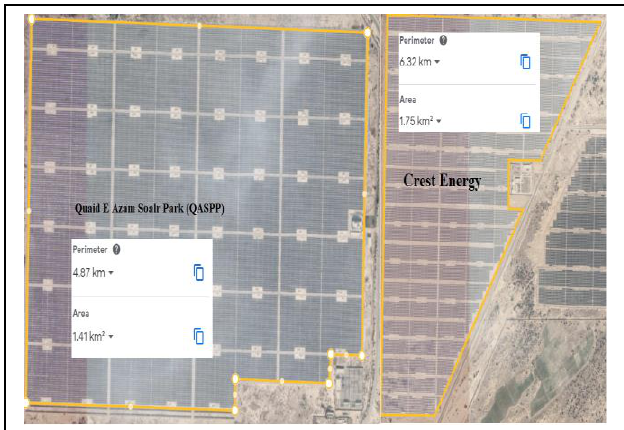
Fig. 7. PV Area measurements of QASPP VS Crest